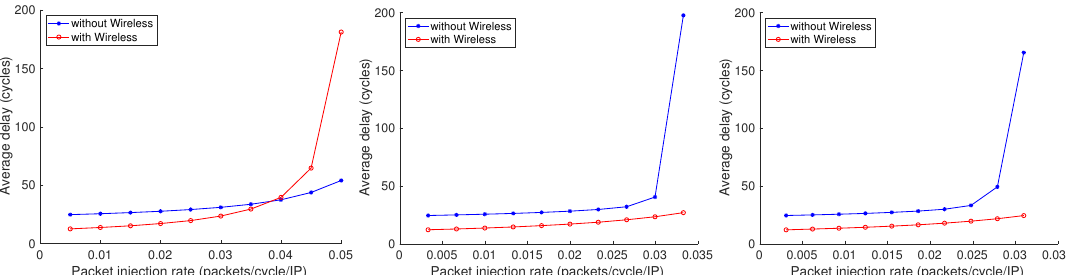
Figure 15. Average delay for profiles T 16 , T 32 , and T 64 for 1024 Delta MIN topology and table-based traffic (TT-1024 Delta MIN).